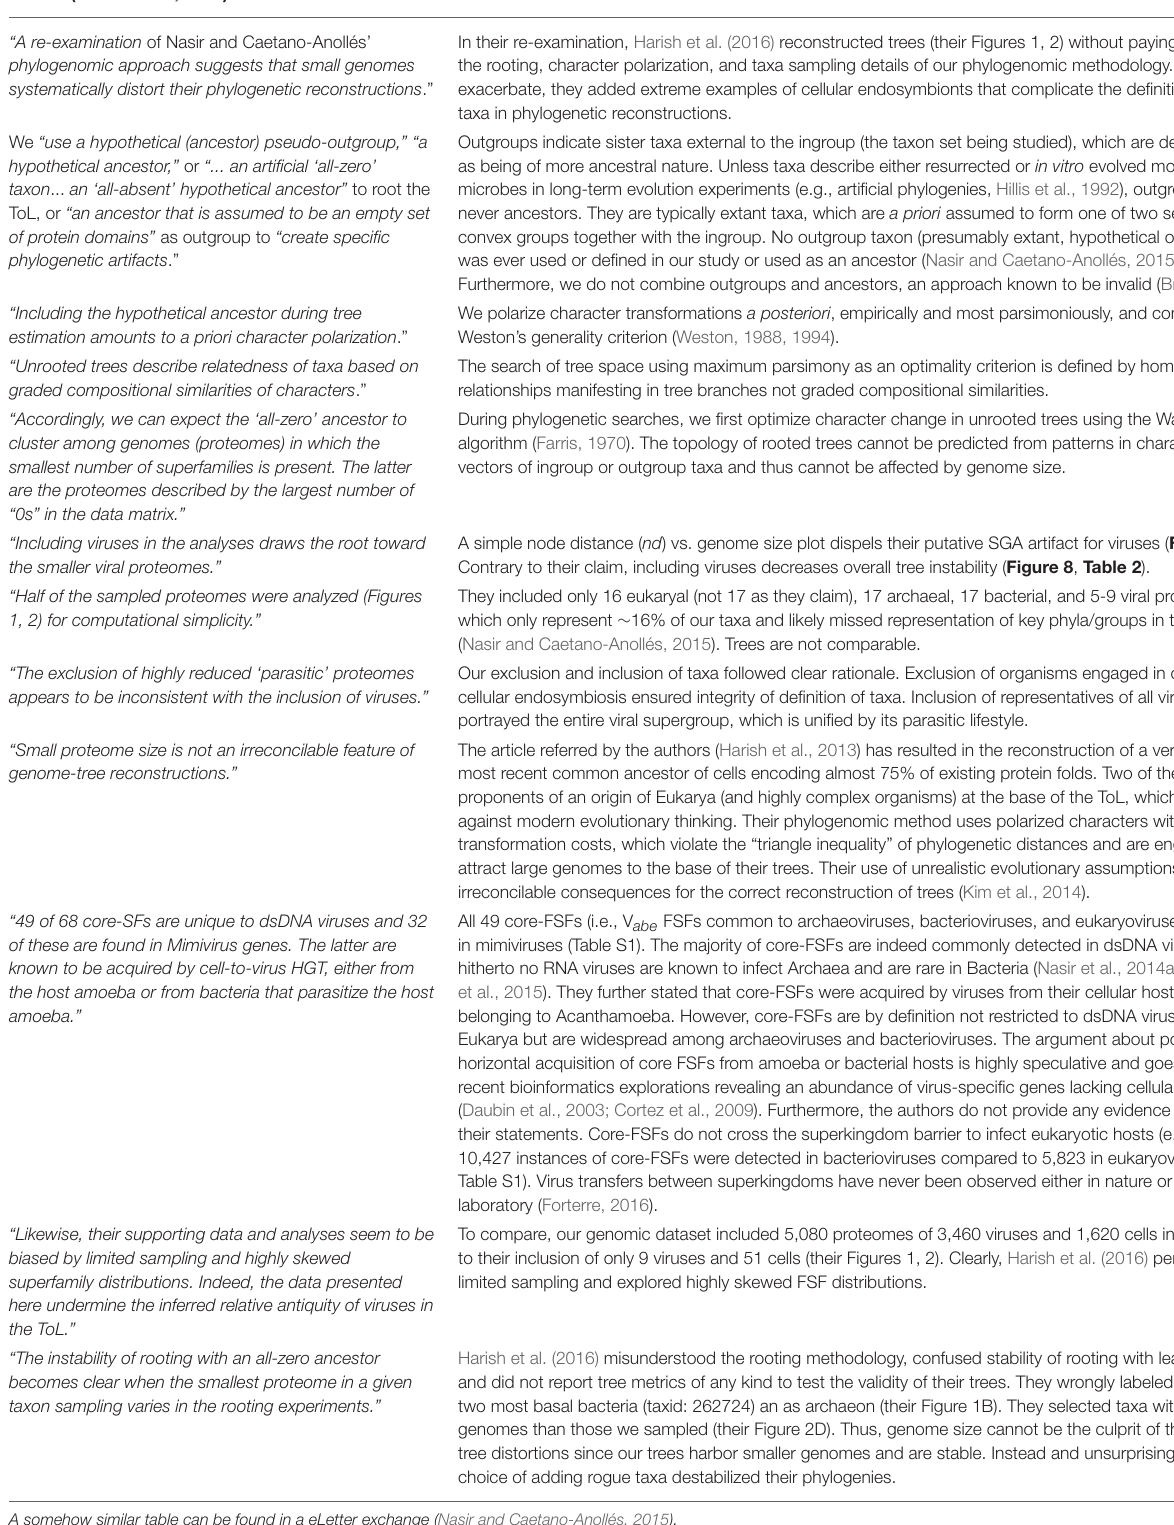
TABLE 1 | Fact-checking the narrative of Harish et al. (2016). Fiction (Harish et al., 2016)